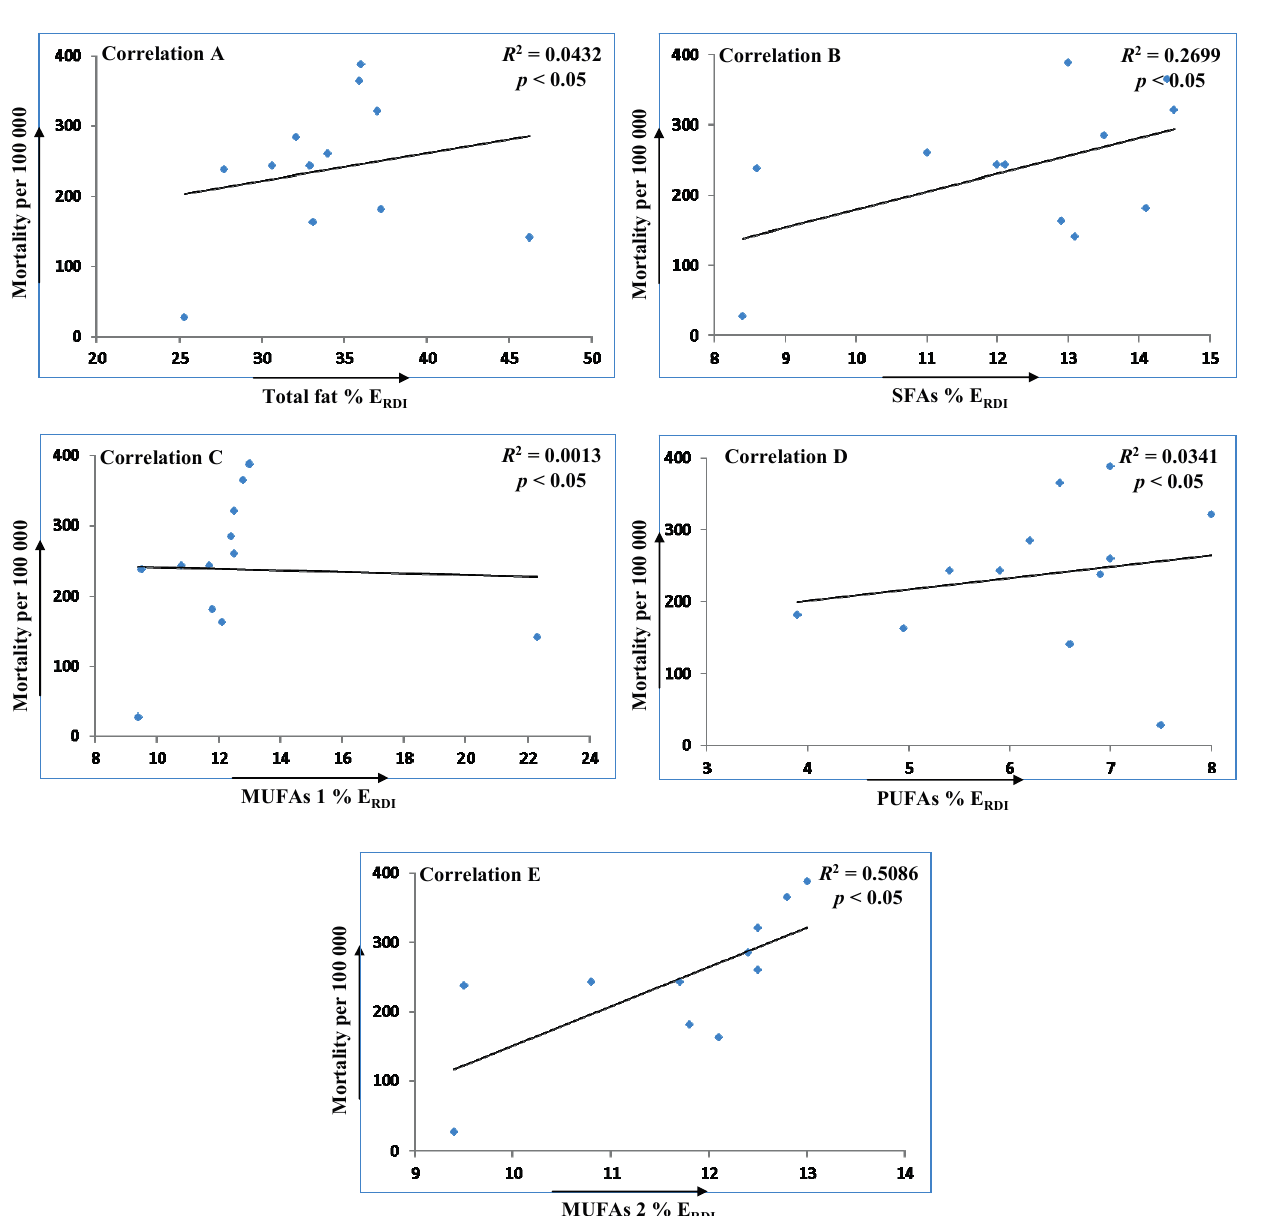
Figure 3. Spearman’s correlations illustrating relationships between CHD and CVD mortality per 100,000 people and intakes (% E RDI ) of total fat ( A ); SFAs ( B ); MUFAs 1 ( C ); PUFAs ( D ) and MUFAs 2 ( E ) in various countries. MUFAs 1 is correlation including all countries, whereas MUFAs 2 is created without data from